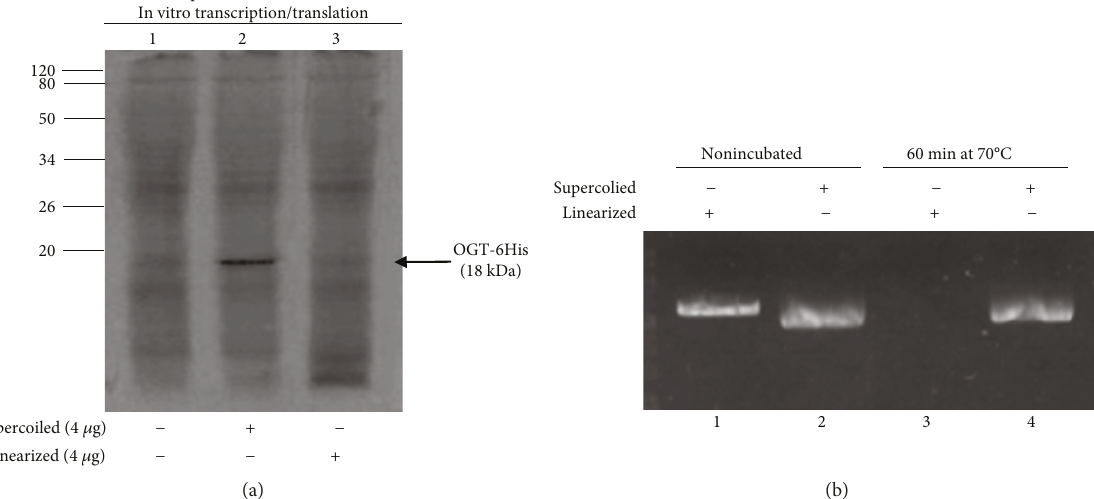
Figure 5: In vitro expression of ogt from linearized plasmid. (a) Supercoiled and linear pBS-rRNA - ogt plasmids were incubated with p S. solfataricus whole cell extract for 60min at 70 ° C with 35 S-Met in a fi nal volume of 25 μ l, and the products of expression were resolved by 16% denaturing polyacrylamide gel electrophoresis. (b) Survival of supercoiled and linear pBS-rRNA - ogt plasmid after incubation in the p S30-coupled system. The constructs were incubated for 60min at 70 ° C under standard conditions and then analysed on a 1% agarose gel. Lane 1, nonincubated linear pBS-rRNA - ogt DNA; lane 2, nonincubated supercoiled pBS-rRNA - ogt DNA; lane 3, linear pBS-rRNA - ogt p p p DNA incubated in an S30 mixture; and lane 4, supercoiled pBS-rRNA - ogt DNA incubated in an S30 p